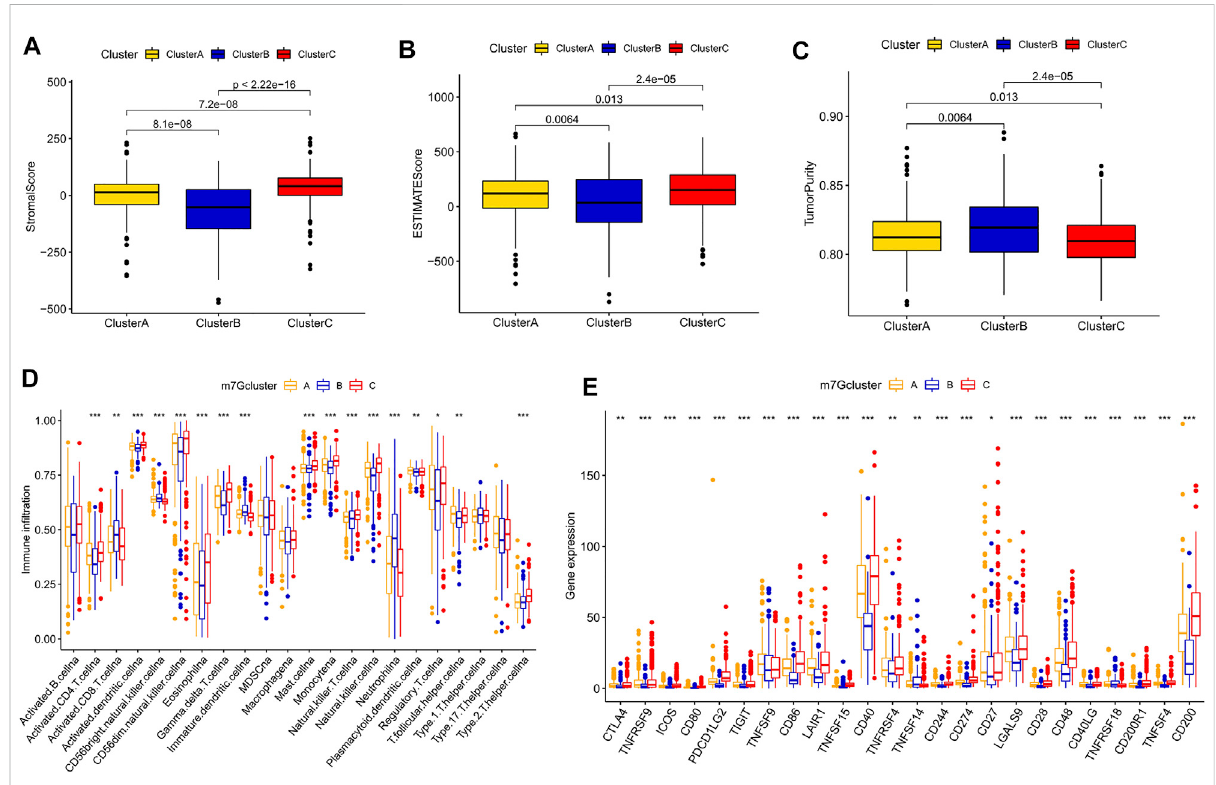
FIGURE 3 Differences in the immune microenvironment among different subtypes. (A – C) Differences in stromal and ESTIMATE scores and tumor purity among different subtypes. (D) Differences in immune cell in fi ltration among different subtypes based on ssGSEA. (E) Differences in immune checkpoint expression among different